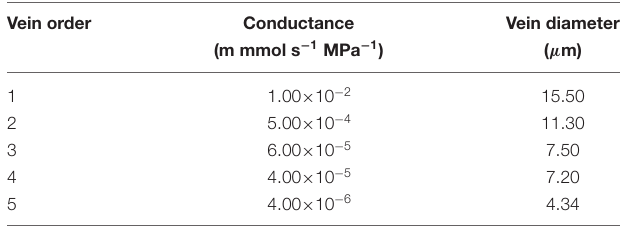
TABLE 3 | Xylem vein conductivities; phloem conductivities are a factor of 3/100 lower. Vein order